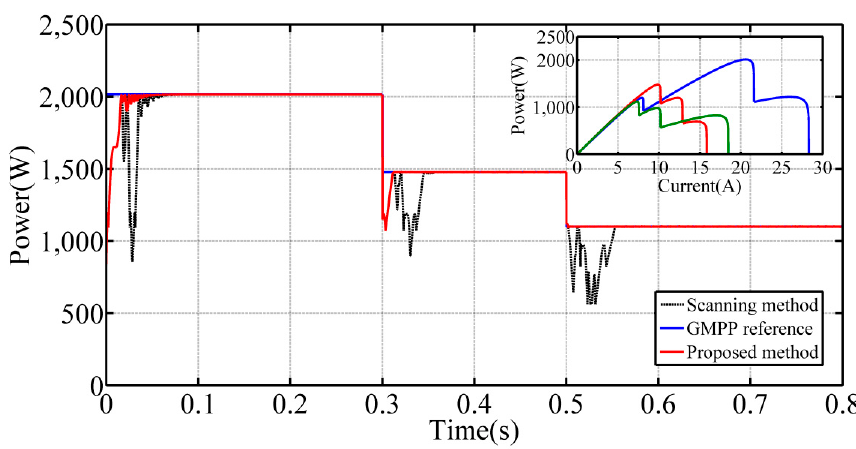
Figure 16. The PV output power for scanning method and OIV-INC algorithm under fast transient variations of shading patterns, with the corresponding P − I characteristic curve.